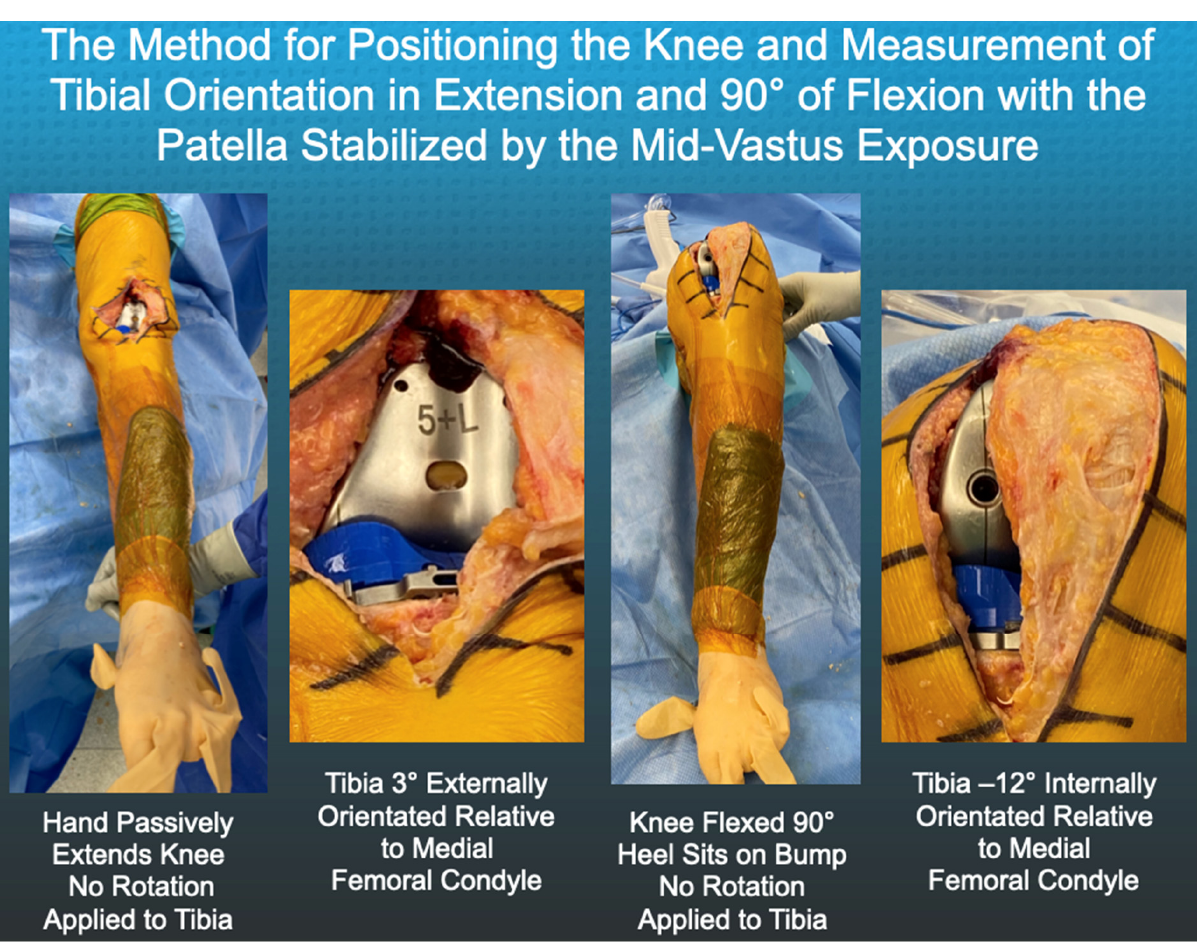
Figure 2. Composite shows photographs of a left leg and the steps for measuring tibial orientation with the insert goniometer. The surgeon passively extended the TKA and measured external tibial orientation of 3°. The surgeon flexed the TKA and measured − 12° of internal tibial orientation at 90° flexion.